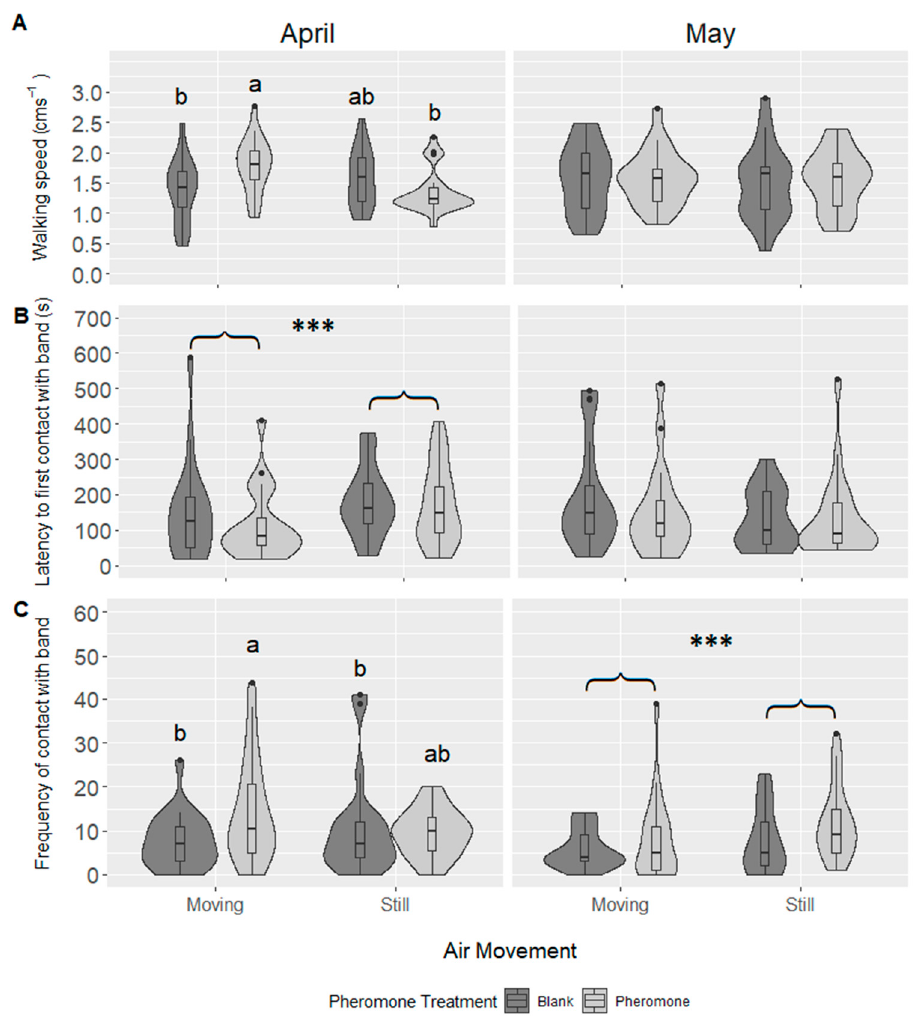
Figure 2. Impact of pheromone and air movement on male Agriotes obscurus click beetles. ( A ) LS mean ( ± SE) walking speed; ( B ) time to first contact with pheromone band; and ( C ) frequency of contacts with band. April: N = 87; May: N = 82. Either side of the violin plot shows the distribution of the data via a probability density, with wider sections indicating values occurring at higher frequency. *** represent significance p < 0.05, as assessed by contrasts in a generalized linear model. Letters represent significance at p < 0.05 (Tukey’s